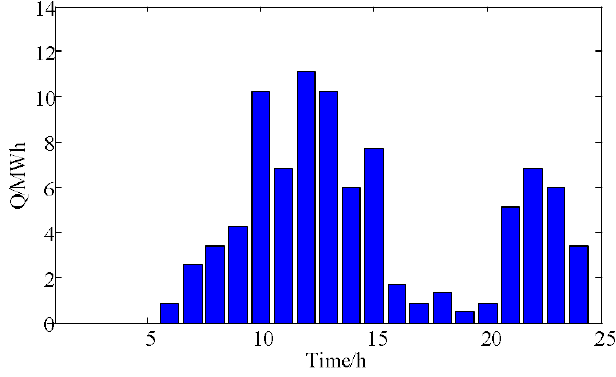
Figure 5. Prediction of battery swapping demand in a typical day.